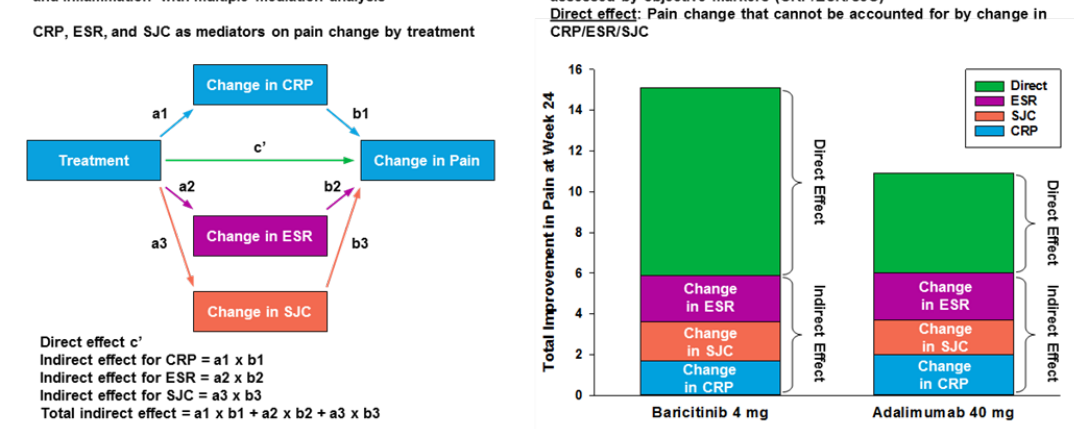
Figure 4. Relative contribution of inflammatory control to pain control.